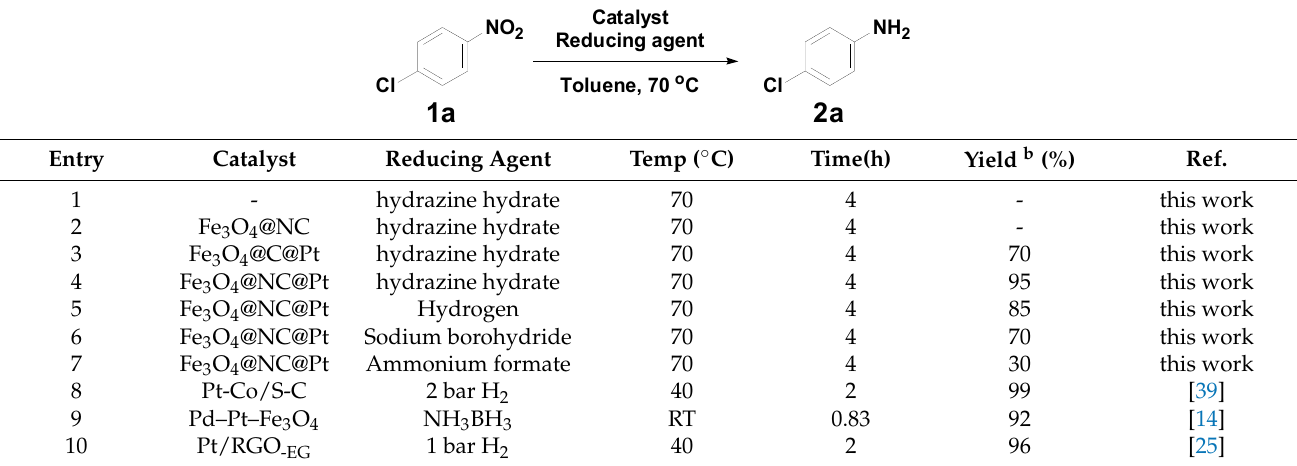
Table 1. Optimization of catalyst and reducing agent a .